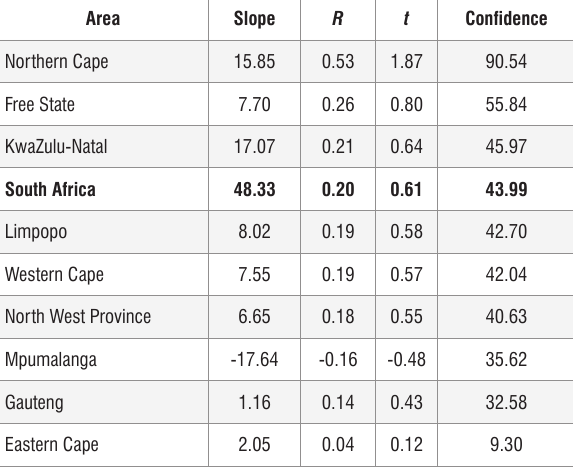
Table 2: Statistics for the whole South African region and individual